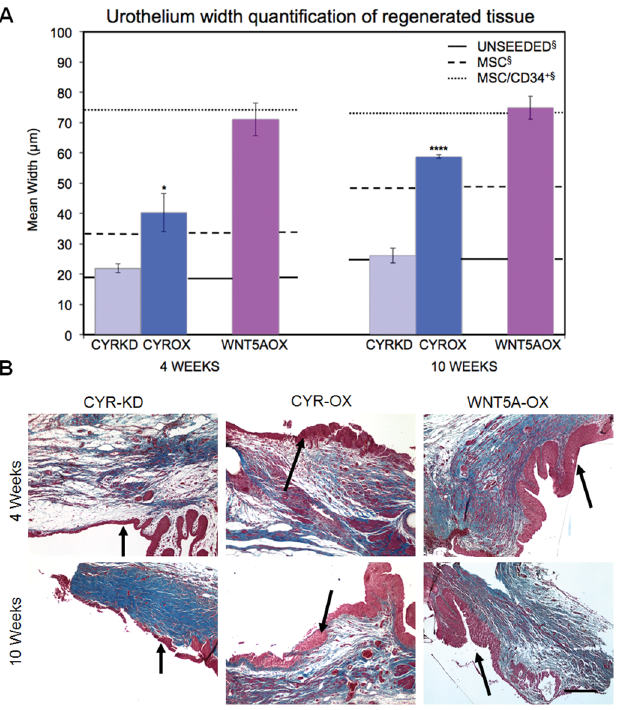
Fig 4. Effects of Cyr61 and Wnt5a on urothelium growth. (A) Wnt5aOX resulted in mean urothelium width similar to MSC/CD34 + HSPCs. Cyr61OX resulted in urothelium width significantly greater than Cyr61KD at both time points. Cyr61KD and unseeded grafts had the thinnest urothelium. Data shown as means ± SEM; * P < 0.05 and **** P < 0.0001 for Cyr61KD vs Cyr61OX. Unseeded, MSC and MSC/CD34 + HSPC data represent new quantitative assessment for a subset of samples from a previous study.[7] (B) Sample photomicrographs demonstrate thickened urothelium with homogenously small nuclei consistent with urothelial hyperplasia in the Cyr61OX and Wnt5aOX groups. Black arrows mark the transition between regenerated and native tissue. Scale bar, 200 μ m. (Unseeded, MSC and MSC/CD34 + HSPC images shown in S2